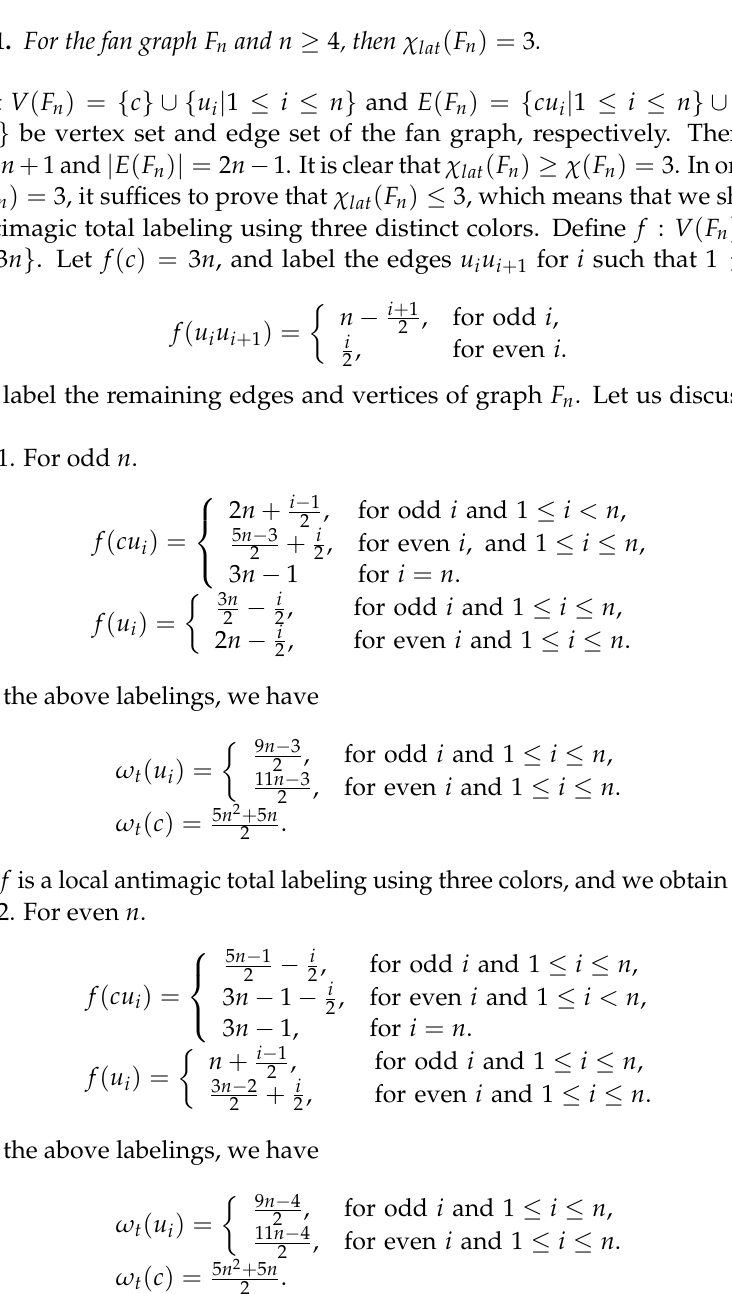
Figure 1. The fan graph F 5